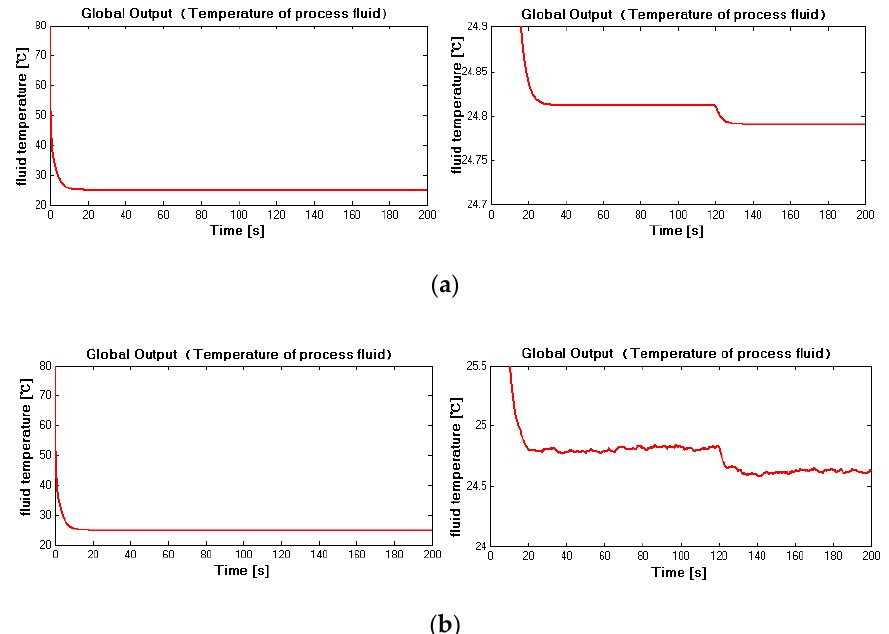
Figure 11. ( a ) Measured T C (noise-free situation) in case 2; ( b ) measured T C (noise-corrupted situation) in case 2.